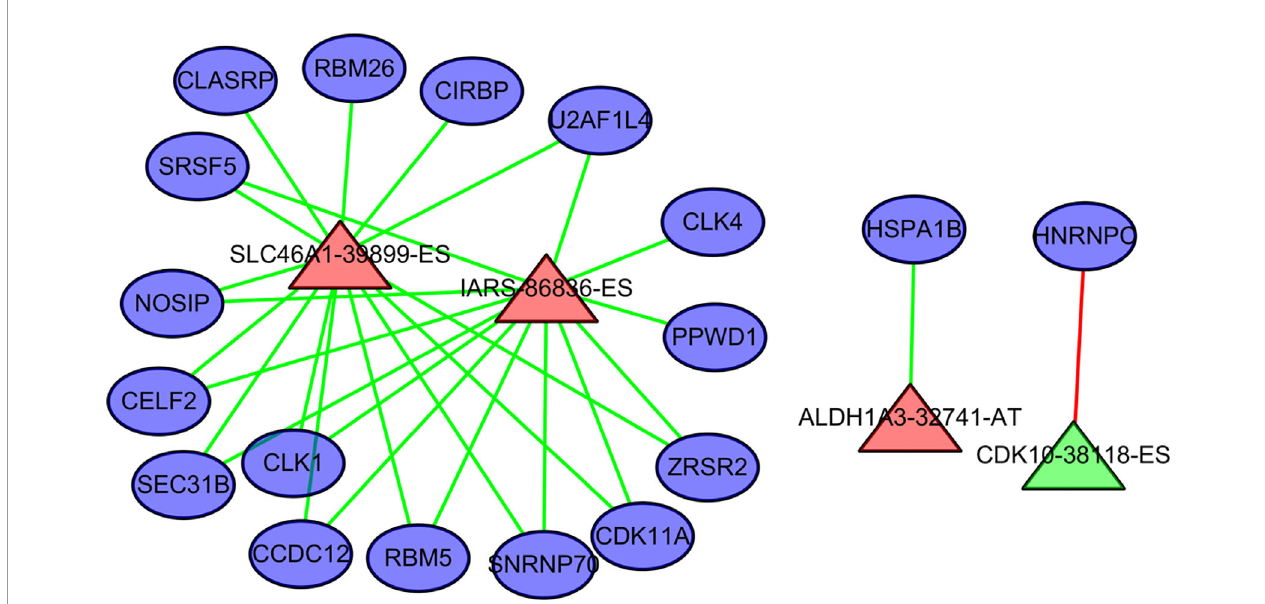
FIGURE 7 | The regulation relationship between alternative splicing (AS) events and splicing factors. The ovals represent splicing factors. The red triangles represent AS events associated with poor outcome in cholangiocarcinoma. Green triangles represent AS events negatively associated with poor outcome in cholangiocarcinoma. The lines between AS events and splicing factors represent the relationship between them. Red lines represent upregulation. Green lines represent